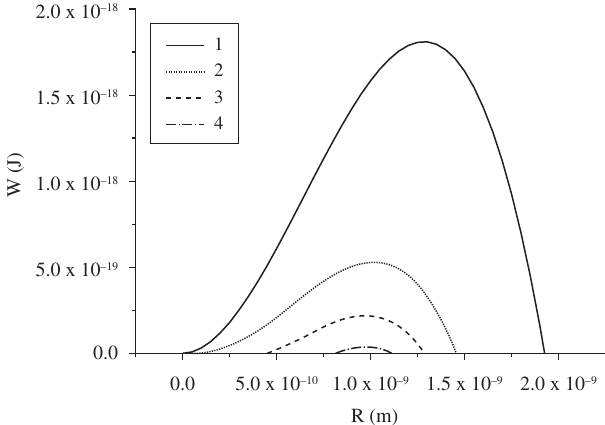
Figure 1. Calculated free energy changing of a model system due to the formation of nucleus as a function of size: (1) σ is size independent; (2) σ is size dependent (Equation (7)); (3) σ is size dependent (Equation (8)); (4) σ is size dependent (Equation (9)). The following parameters were used: